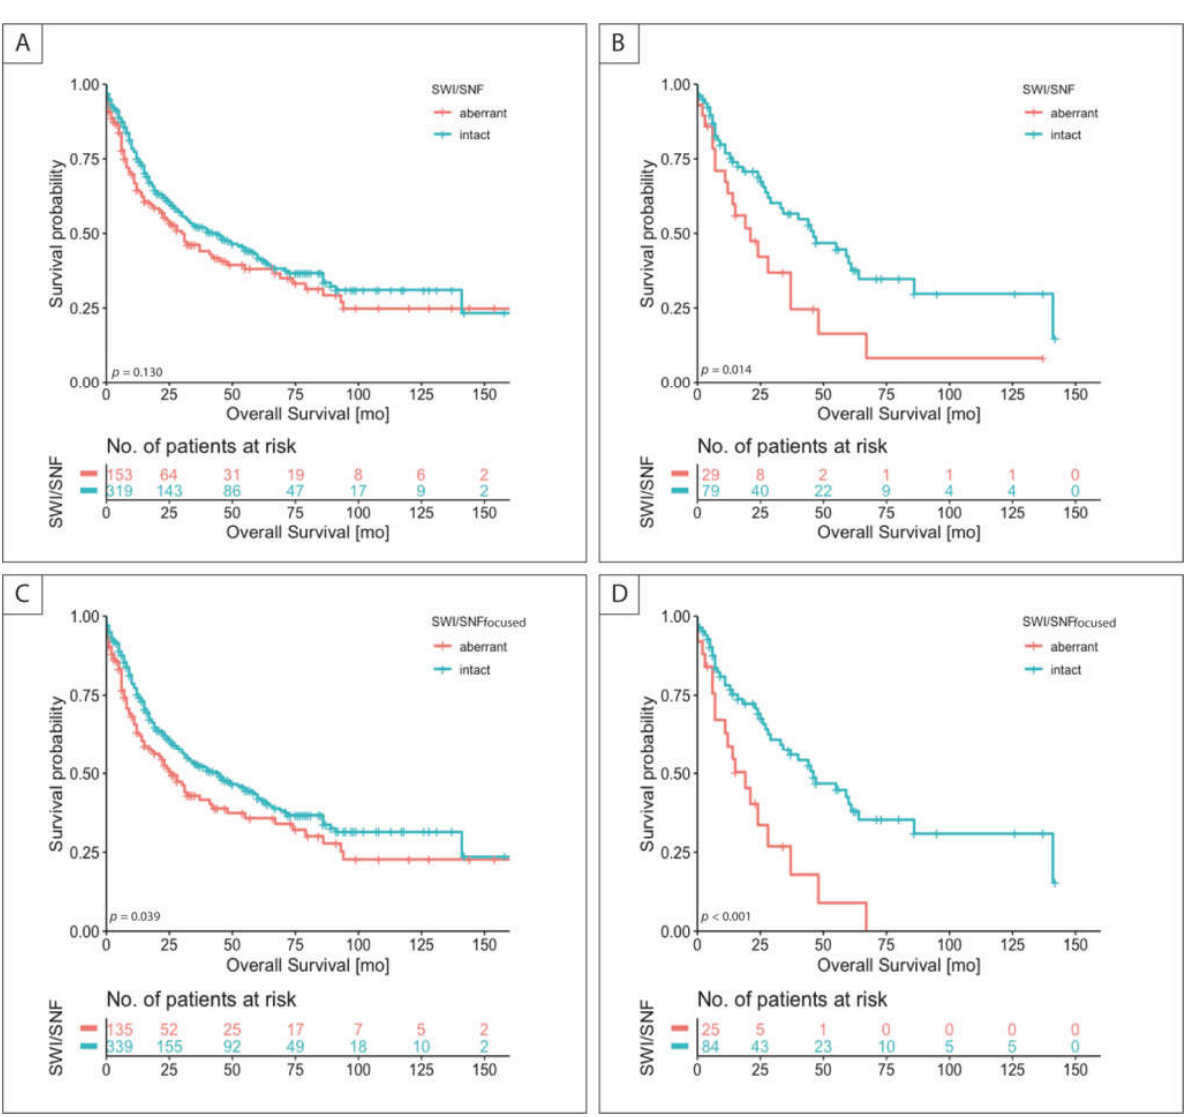
Figure 3. Discrimination of patient survival by SWI/SNF and SWI/SNFfocused status. Kaplan–Meier curves of patients with aberrant and intact proteins of the SWI/SNF complex are shown. SWI/SNF in all cases ( n = 472) ( A ), in tumors classified as GS ( n = 108) ( B ) and SWI/SNFfocused in all cases ( n = 473) ( C ), and in GS tumors ( n = 109) ( D ); p -value of log-rank test.